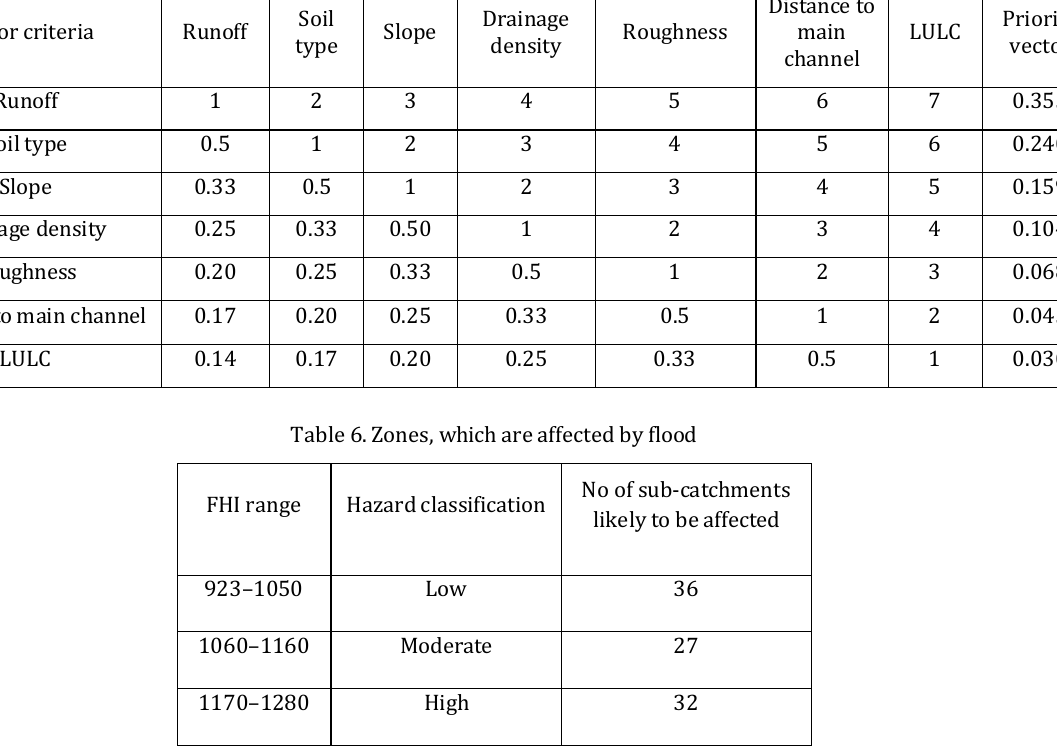
Table 5. Relative importance weights (RIWs) for factor criteria and Pairwise comparison matrix Factor criteria